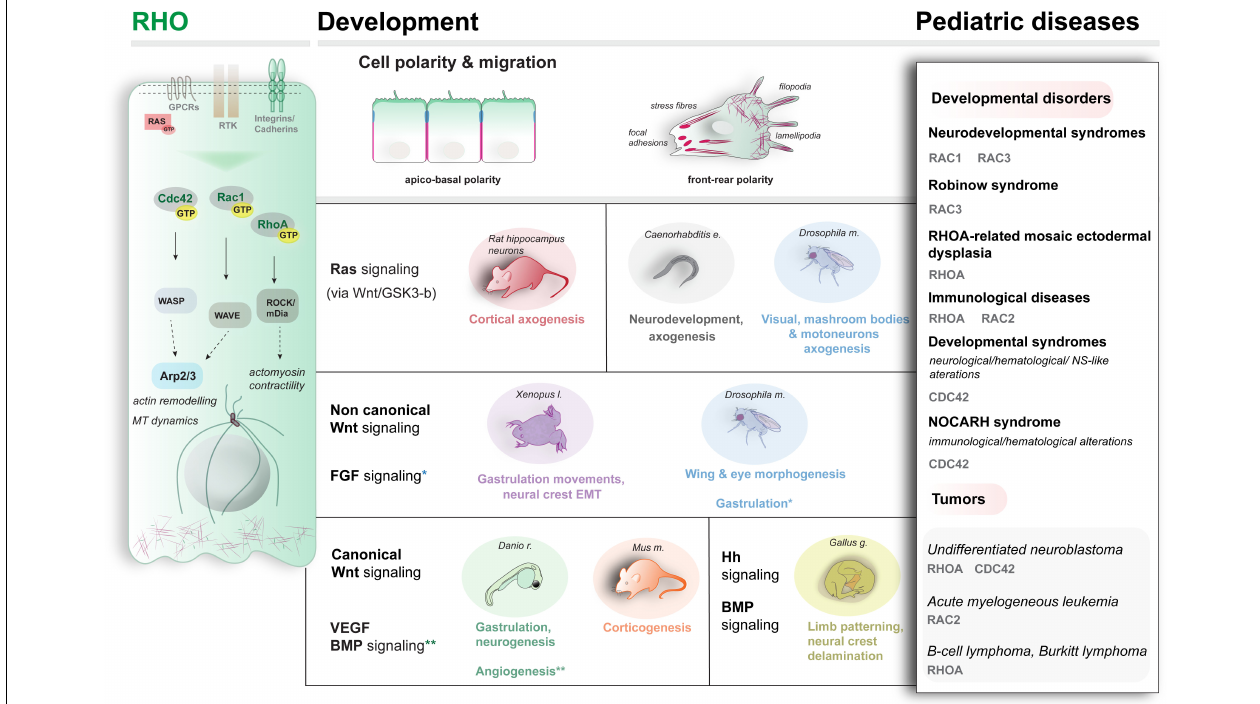
which recapitulate the human condition and associate with tumorigenesis (Santoriello et al.,